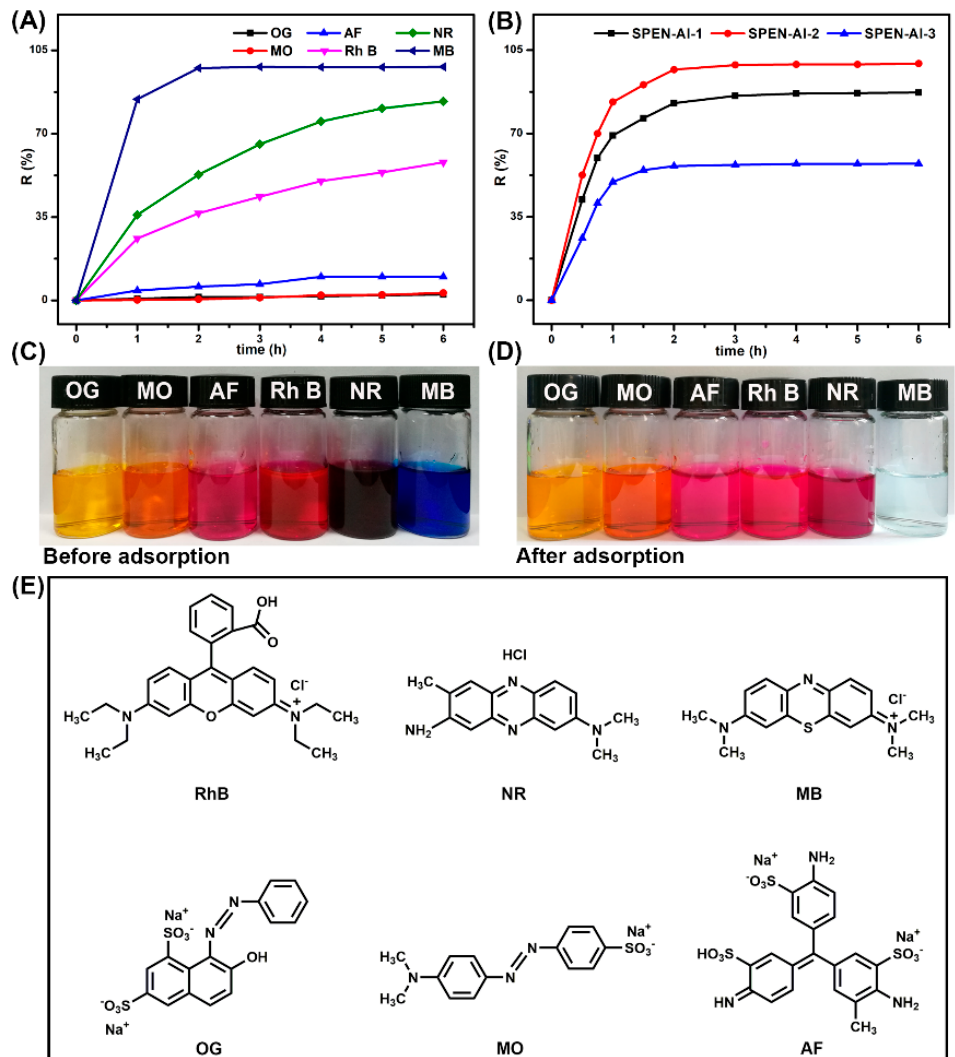
Figure 4. Effect of contact time on the removal efficiency of six dyes by the certain SPEN-Al-2 adsorbent ( A ) and the removal efficiency of MB by three different SPEN-Al adsorbents ( B ). Digital photos of the organic dyes in aqueous solutions before ( C ) and after ( D ) adsorption by SPEN-Al-2. Chemical structures of organic dyes (Rh B, NR, MB, OG, MO and AF) selected for adsorbent ( E ).